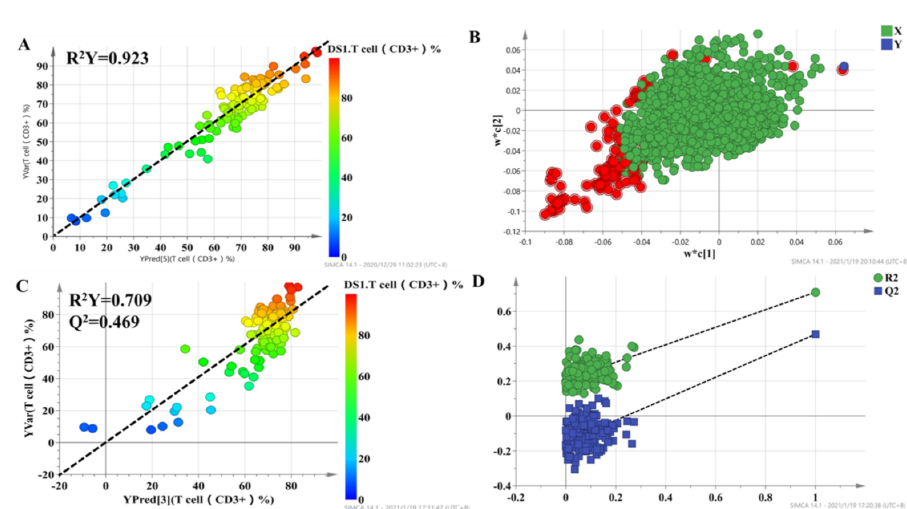
Figure 3. The score plot for the initial PLS model ( A ) and second PLS model ( C ), in which the color from blue to red represents the response variable from low to high. Loading plots for the percentage of T lymphocyte prediction model ( B ), in which the blue box represents the response variable; each circle represents a metabolic feature, and the circle in red represents metabolic features with VIP > 1.5. Internal validation of the second PLS model ( D ) was performed using 200 permutation